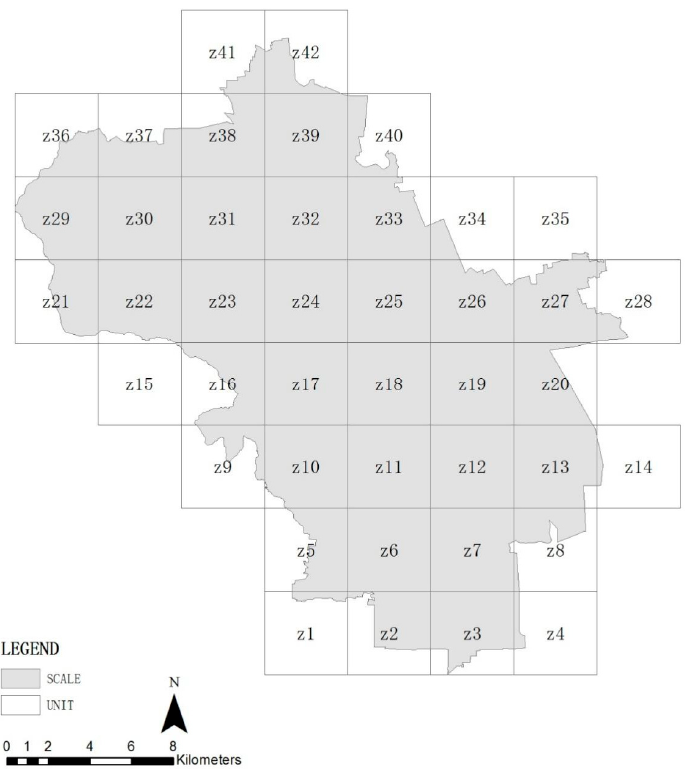
Figure 4. Research units in Haidian District.